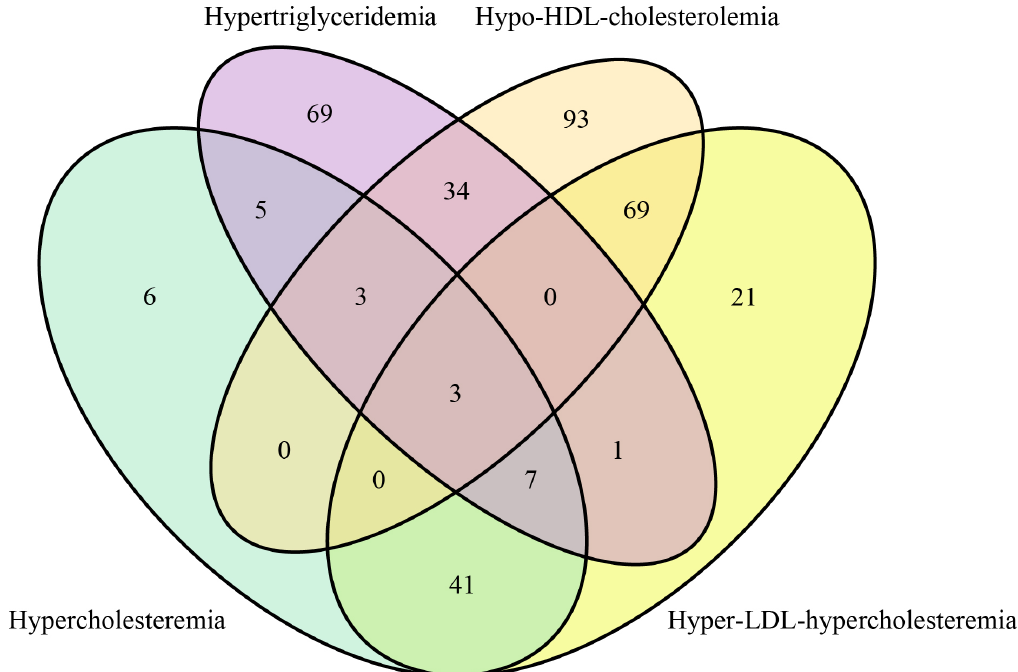
Figure 2. Venn diagram of sample distribution of four types of dyslipidemia subjects.